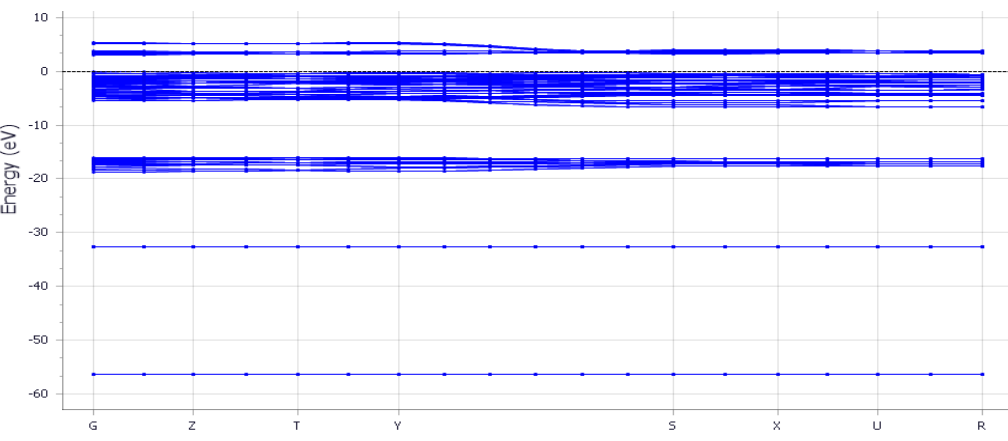
Figure 3. Energy band structure of Al 2 TiO 5 crystal.